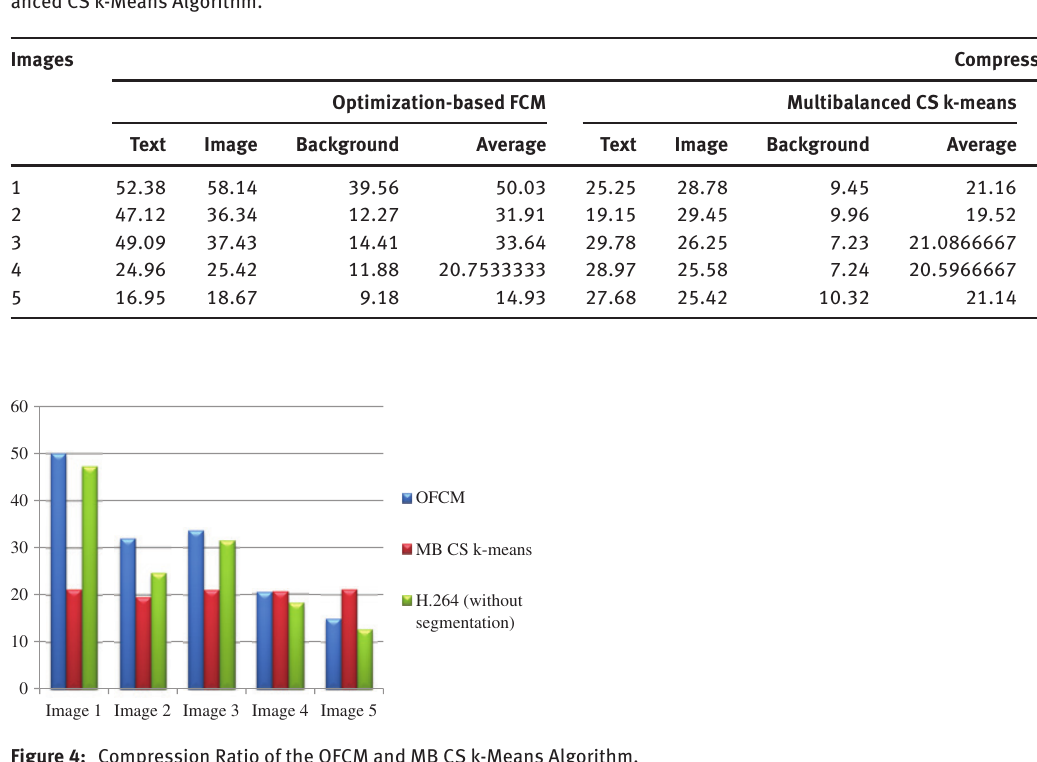
Table 1: Compression Ratio of the Text, Image and Background during Segmentation by Optimization-Based FCM and multibal- anced CS k-Means Algorithm.